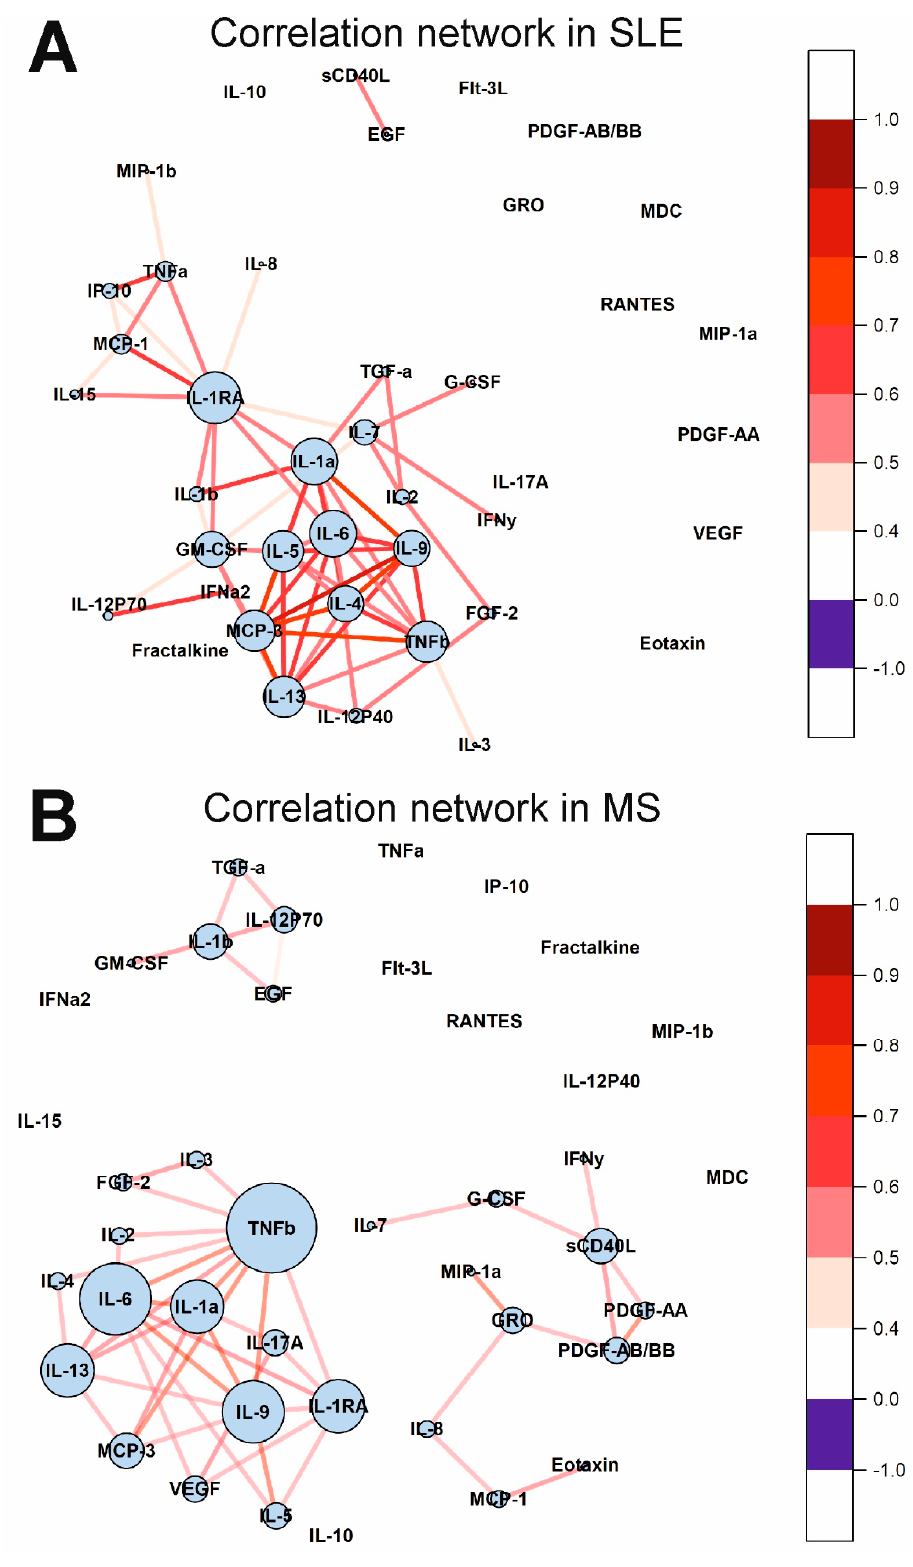
Figure 7. Cytokine correlation networks in SLE ( A ) and MS ( B ). Correlations between concentrations of different cytokines are shown as colored lines. A scale showing the strength and direction of the correlation is shown in the right panel. Each cytokine is represented by a blue circle whose size is proportional to the number of statistically significant correlations.